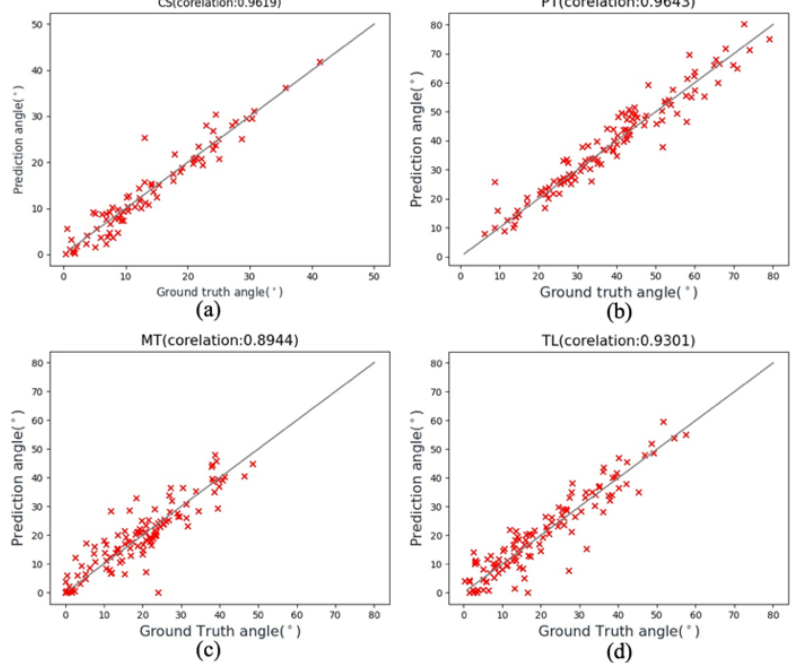
Figure 5. Bland–Altman difference diagrams. ( a ) Diagram for our own dataset. ( b – d ) are the diagrams for the public datasets. Each cross represents the prediction and ground truth value of the Cobb angles.